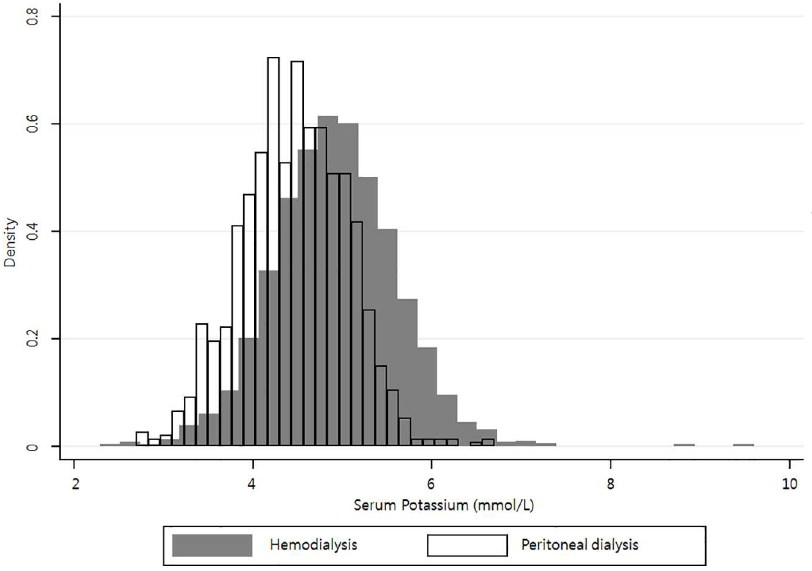
Fig 1. Distribution of serum potassium levels according to dialysis modality. The distributionis left- shifted in patients undergoingperitonealdialysis.